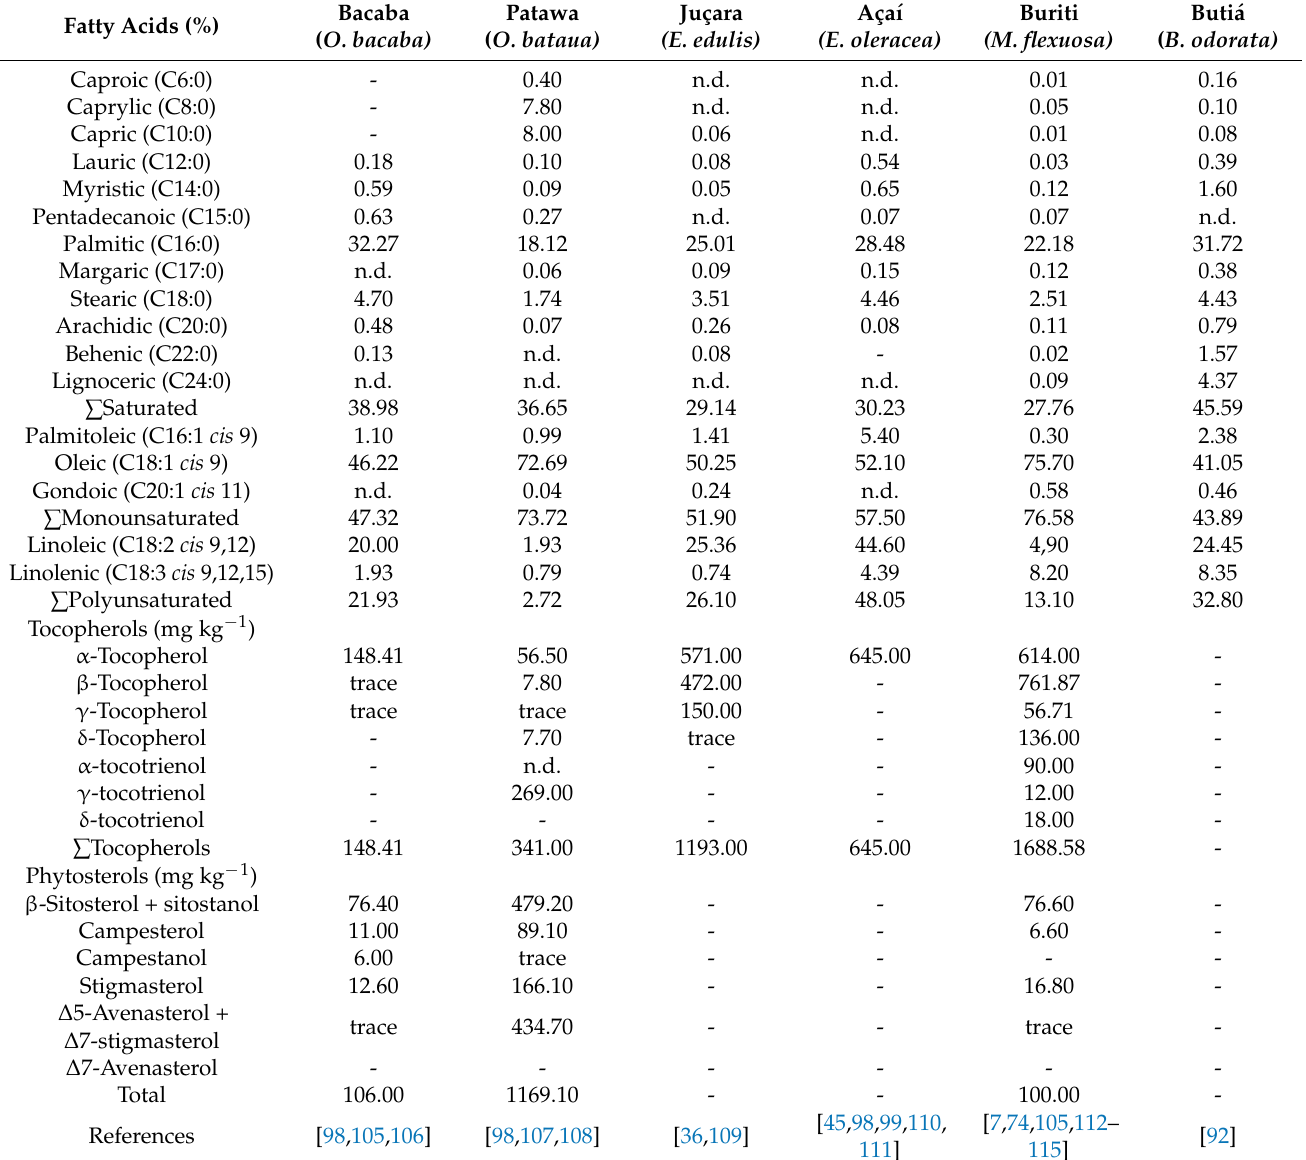
Table 2. Lipid composition of fruits belonging to the Arecaceae